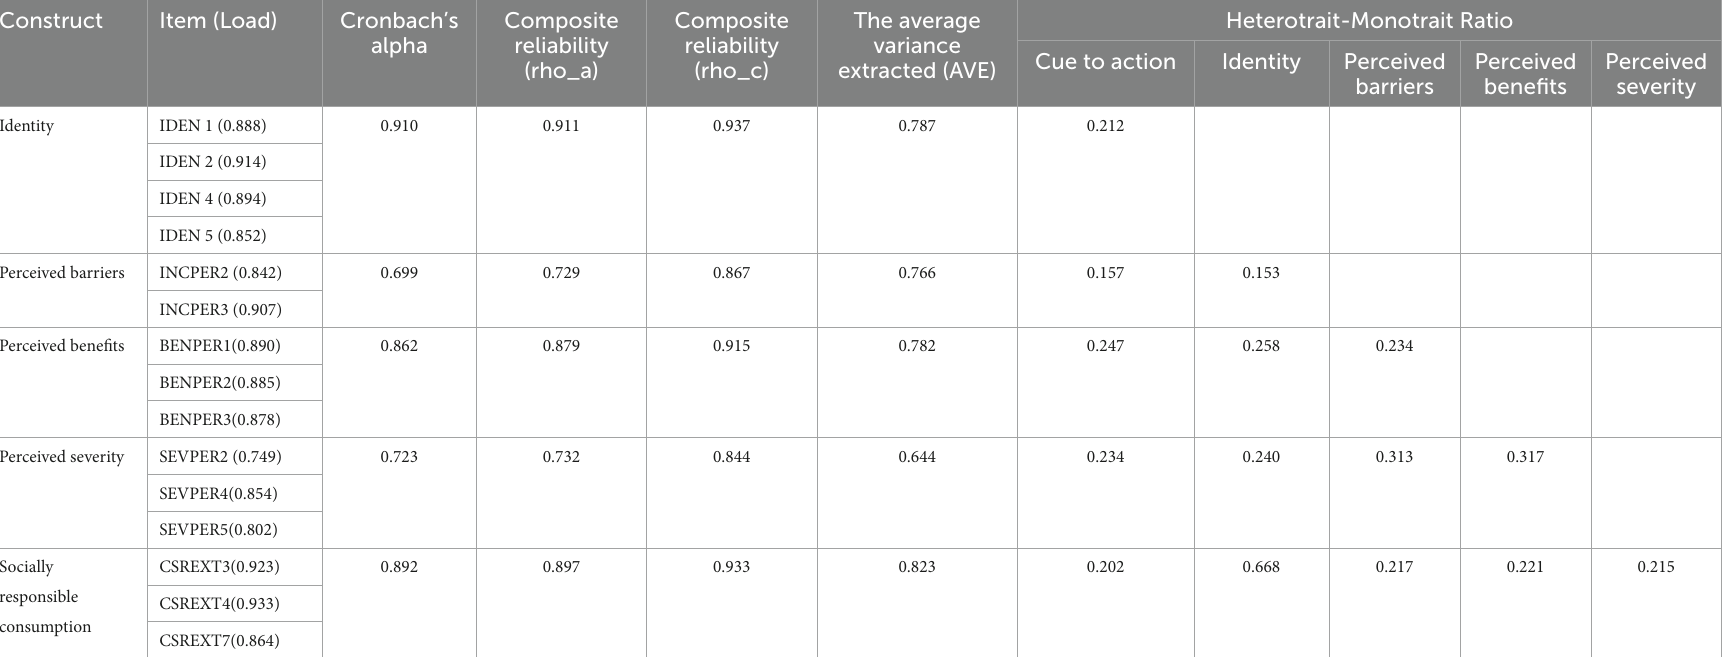
TABLE 6 Measurement model evaluation